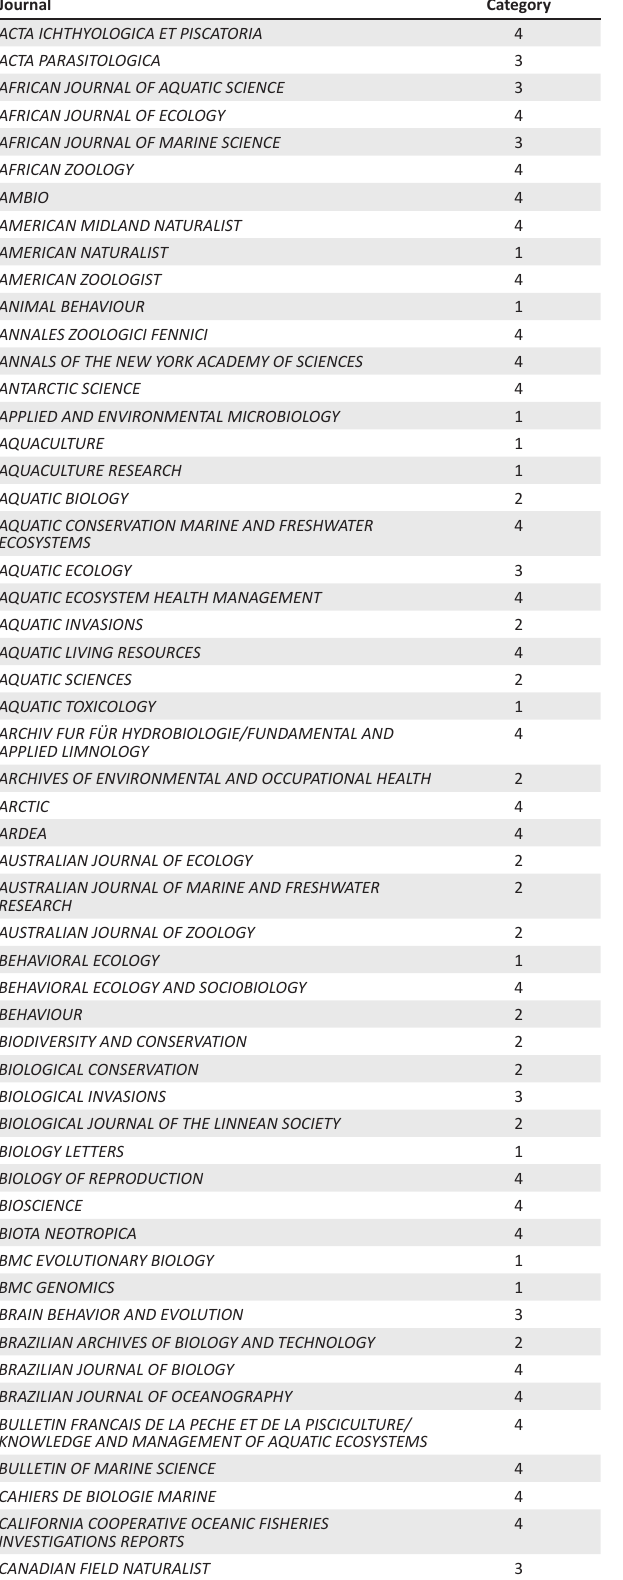
TABLE 1-A1: Categorisation, based on animal ethical requirements, of 250 ISI- rated, peer-reviewed, scientific journals with the most articles relating to fish research, revealed through a Web of Science (Thomson Reuters) search.